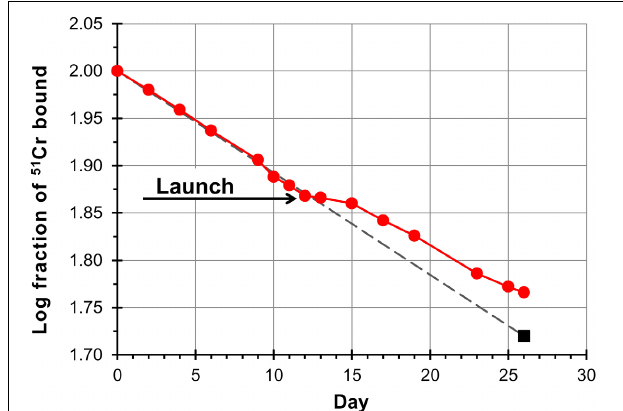
FIGURE 2 | Red cell survival on SLS-2 space mission. Data points are a composite of results from three astronauts. Red cell survival is normal pre-launch whereas the inflection in the curve beginning at launch has been interpreted as the result of destruction of unlabeled erythrocytes (neocytes), and a consequent increase in the concentration of labeled cells. The last point (square symbol) is based on the measured chromium remaining, corrected for the cell mass measured on landing day. The fact that the trend line (dashed line) generated from preflight values transects this point demonstrates that older labeled red cells are removed from the circulation at the same normal rate in space as on Earth. Redrawn from Rice and Alfrey